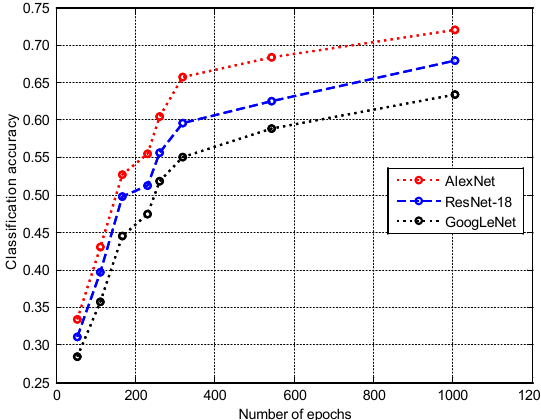
Fig. 4 Classification accuracy of training models of DNN with three pre-trained